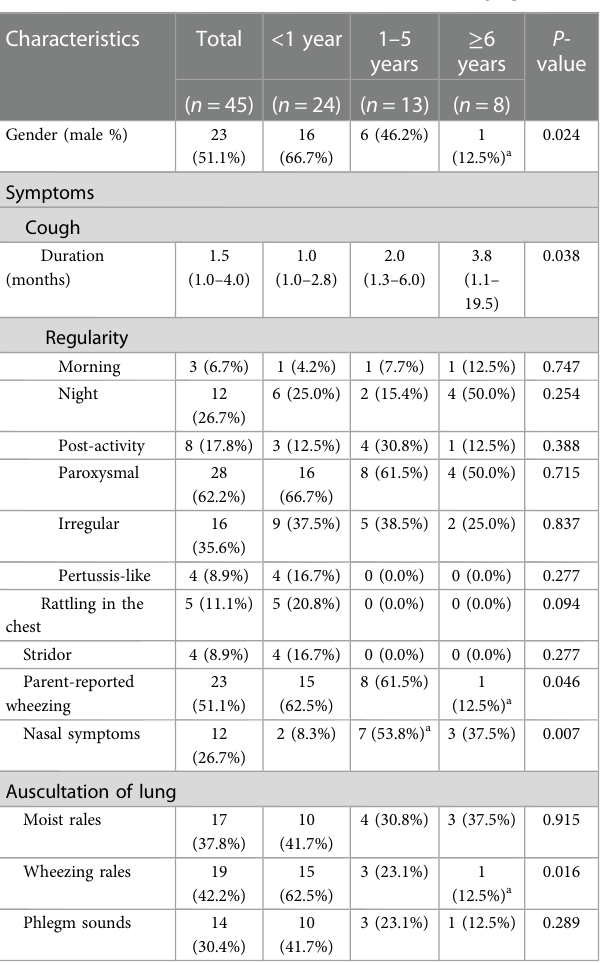
TABLE 1 Clinical characteristics of PBB children strati fi ed by